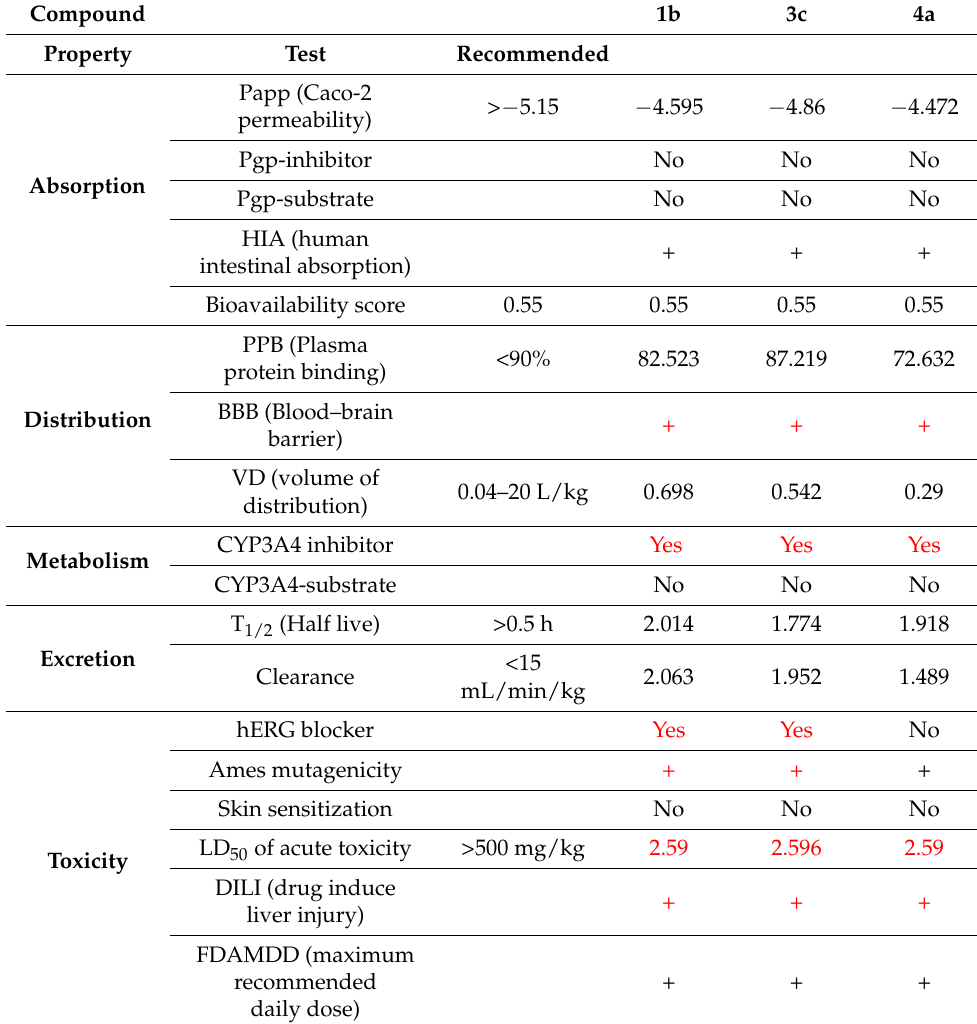
Table 8. Our compounds demonstrated excellent oral absorption; they showed good caco-2 permeability and low papp efflux (<5.15), none of them are expected to be a substrate or inhibitor of p-glycoprotein, and they all tested positive for human intestine absorption and had a high score of oral bioavailability. They also showed acceptable distribution profiles, with a volume of distribution within the optimal range (0.04–20 L/kg) and reasonable bind- ing to plasma protein within the accepted level (<90%), but all studied derivatives showed high probability to cross the blood–brain barrier. With respect to metabolism, they proved to be inhibitors of CYP3A4, but none of them are expected to be a substrate of the same CYP isoform. They showed excreted T 1/2 > 1.5 h and clearance lower than 2.5 min/kg/L, which is considered an accepted excretion profile during the drug development process. On the other hand, they showed a suboptimal toxicity profile by demonstrating high probability for the inhibition of hERG, high probability for acute toxicity, and hepatic injury, but they did not cause skin sensitivity at the maximum recommended dose. Table 8. Estimated ADMET properties of compounds 1b , 3c , and 4a . Red color means unfavorable property. Compound 1b